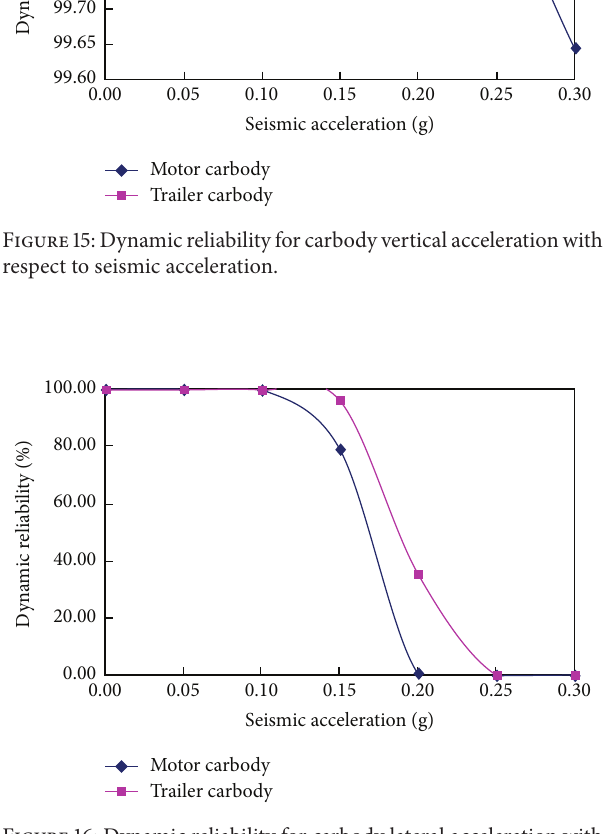
Figure 19:Dynamic reliability forcarbody vertical acceleration with respect to pier height.